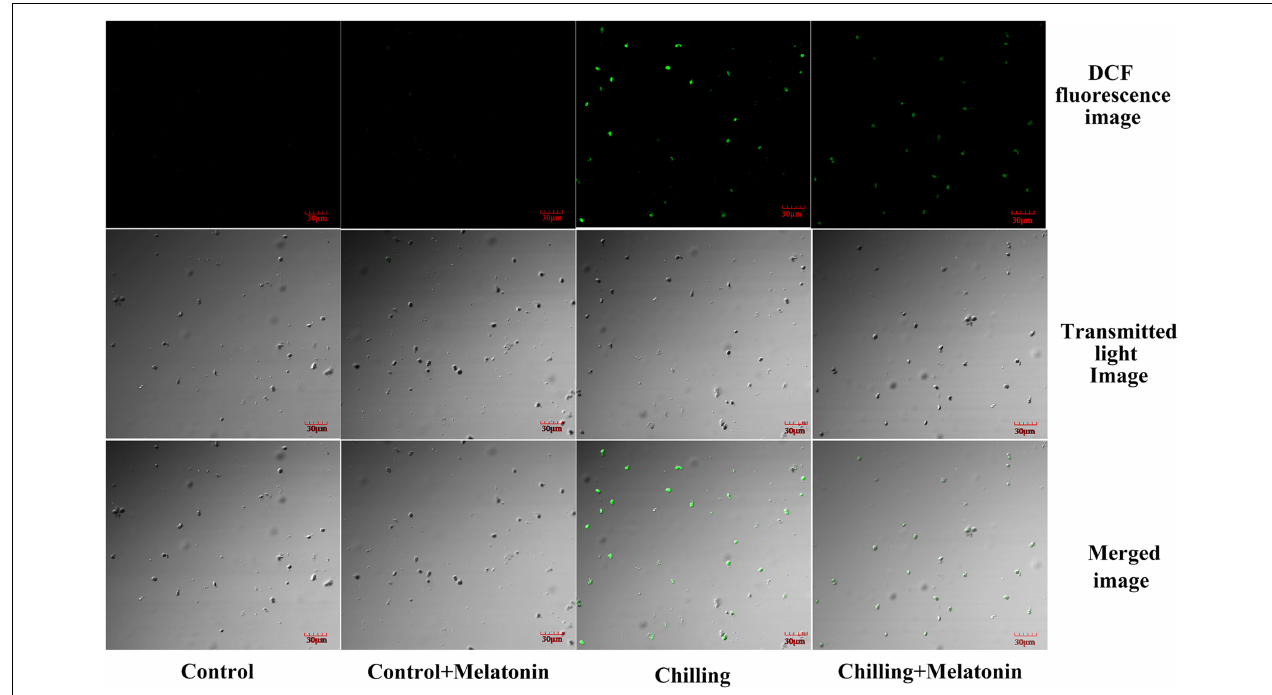
FIGURE 5 | Confocal laser scanning micrographs of DCFH-infiltrated chloroplast. The second, fully expanded leaves were measured after 4 days of chilling. Control (28/18 ◦ C); Control + Melatonin (200 µ M melatonin, 28/18 ◦ C); Chilling (15/8 ◦ C); Chilling + Melatonin (200 µ M melatonin, 15/8 ◦ C). DCF fluorescence, indicative of H 2 O 2 ; Transmitted light image, indicative of the number of chloroplasts; Merged image, combination of DCF fluorescence image and Transmitted light